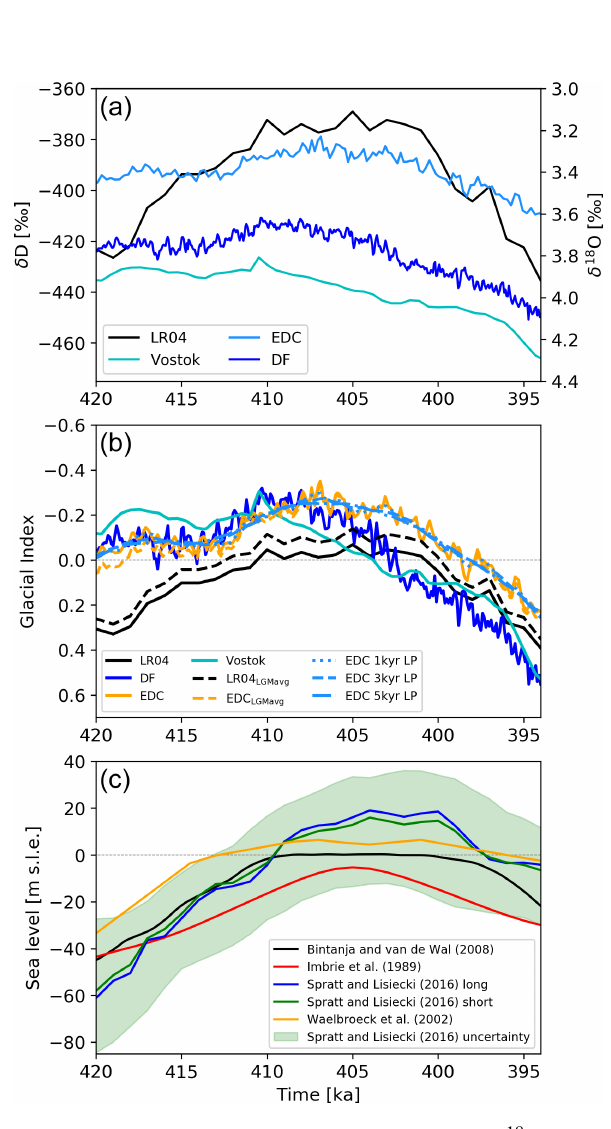
Figure 2. Reconstructions used in this study: (a) LR04 δ 18 O (black) and Vostok, Dome C (EDC), and Dome Fuji (DF) ice core δ D [‰]; (b) resulting glacial indices from the reconstructions in panel (a) (see Sect. 2 and Table 3 for the legends); (c) global mean sea level anomaly relative to PI (metre sea level equivalent,